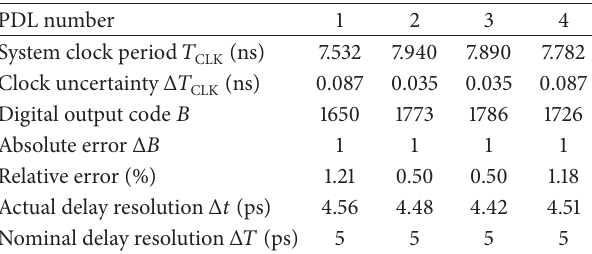
Table 2: Brief comparison of the four